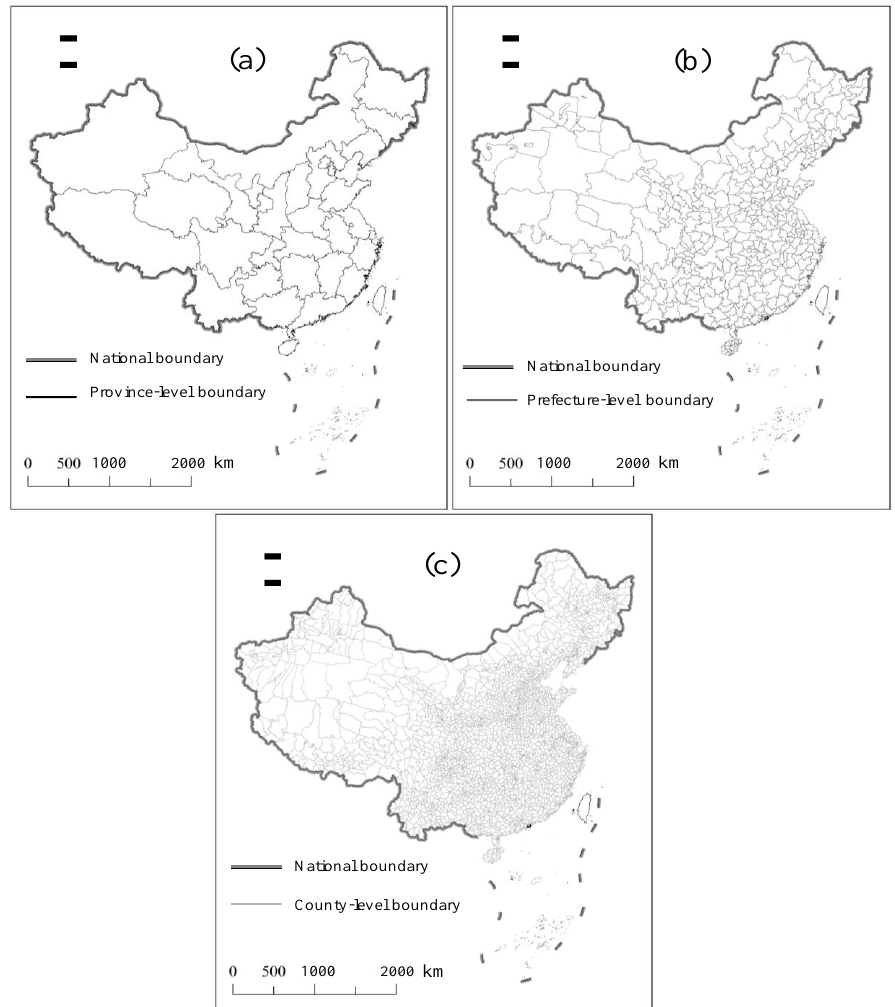
Figure 2. Maps of the study areas: (a) provinces, (b) prefectures, and (c) counties.